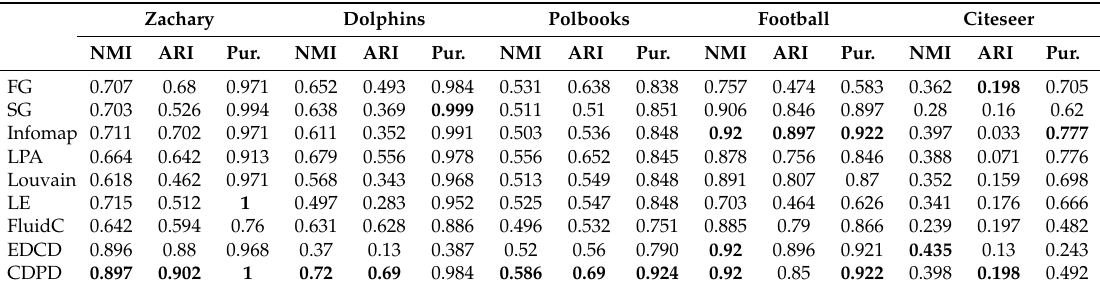
Figure 4. The communities obtained in different networks by CDPD. ( a ) community structure obtained by CDPD on Karate, ( b ) community structure obtained by CDPD on Dolphins, ( c ) community structure obtained by CDPD on Polbooks, ( d ) community structure obtained by CDPD on Football. Table 5. Performances of the above algorithms in real-world networks with ground truth. Zachary Dolphins Polbooks Football